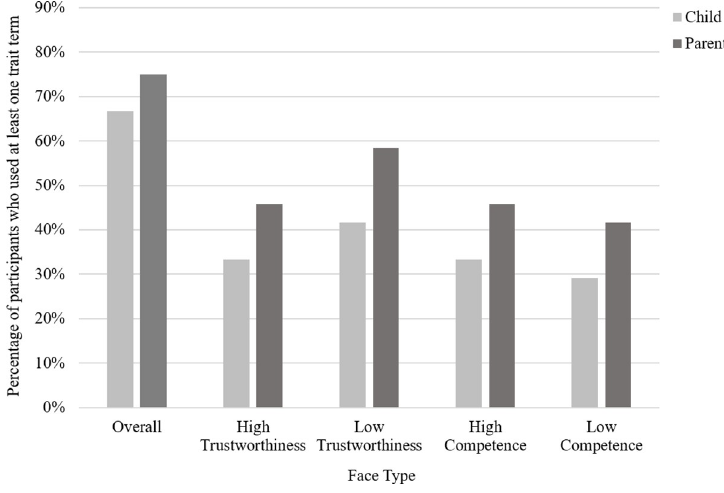
Fig 3. Study 1: Bar graph showing the percentage of parents (N = 24) and children (N = 24) who used at least one trait term during conversation, shown overall and separated by face type. Emotion terms Topic of conversation. In addition to discussing character traits, parents and children discussed the apparent emotions of each character. Overall, combined discussion about emo- tions made up 9.81% of parent and child’s conversation about the faces. Broken down individ- ually, emotion discussion made up 9.82% of parents’ total conversation and 9.78% of children’s conversation. Illustrative examples of parents’ trait conversation are given below. Example 4.